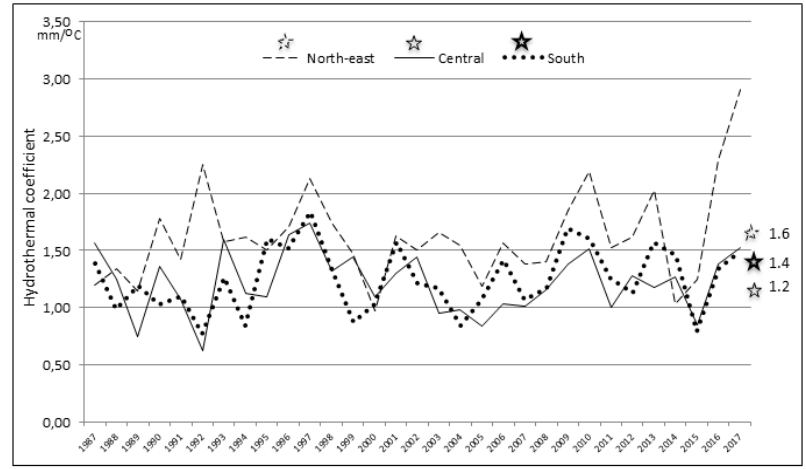
Figure 5. Values of Sielianinov’s hydrothermal coefficient, K ( K = P × 10/ Σ t) for three regions of Poland during the last 30 years (lines) and multi-year average (stars), where P is the sum of precipitation and Σ t is the sum of average temperatures during the period. Ranges of K values for the period are interpreted as extremely dry (0 to 0.4), very dry (0.41 to 0.70), quite dry (0.71 to 1.0), dry (1.1 to 1.3), optimal (1.31 to 1.6), moist (1.61 to 2.0), wet (2.1 to 2.5), and very wet (>2.5).